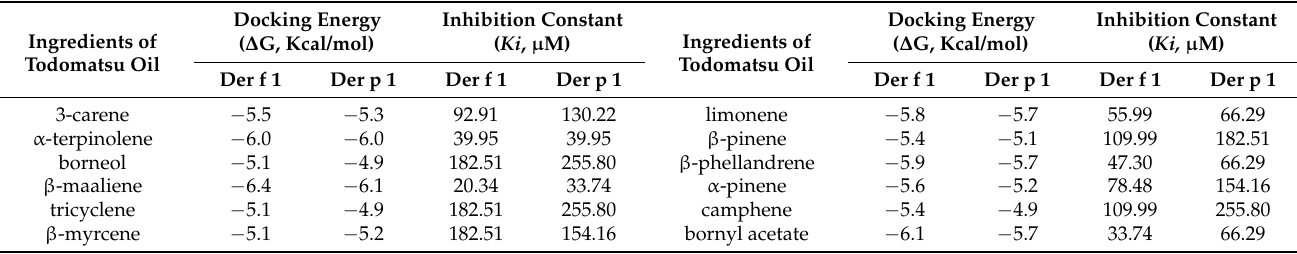
Table A2. Binding affinity (BA) score and inhibition constant ( Ki ) of ingredients-of-todomatsu oil on allergens Der f 1 and Der p